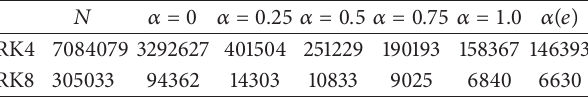
Table 3: Number of steps to get a precision of |Δ ⃗𝑟| < 10 −4 Km.